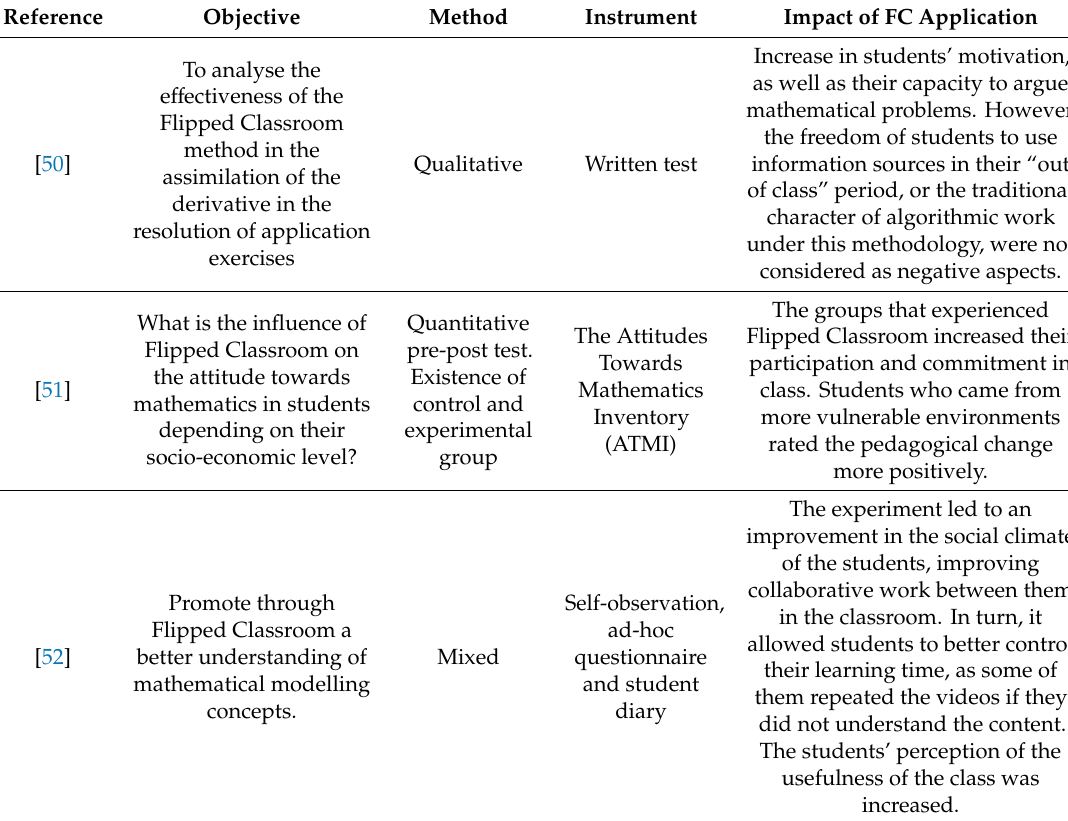
Table 4. Mathematical content covered in each educational